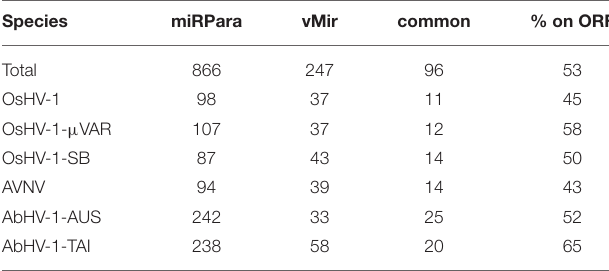
TABLE 8 | miRNA prediction results. miRPara and vMir predictions are reported for the six Malacoherpesviridae genomes, with total number of predicted regions, common ones and percentage of those located in